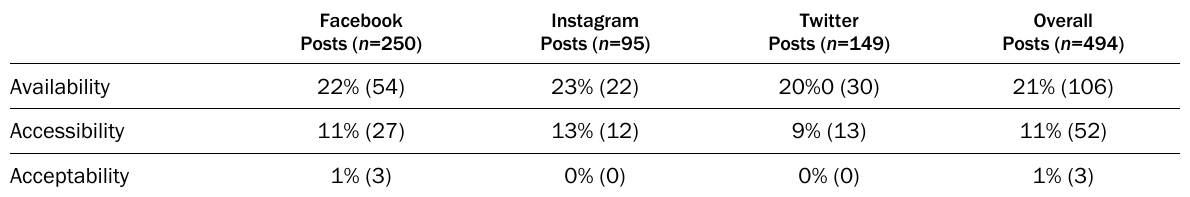
Table 6. Proportion of Seattle Food Bank Social Media Posts that Communicated Themes Related to Food Availability, Accessibility, and Acceptability in April and May, 2020, by Social Media